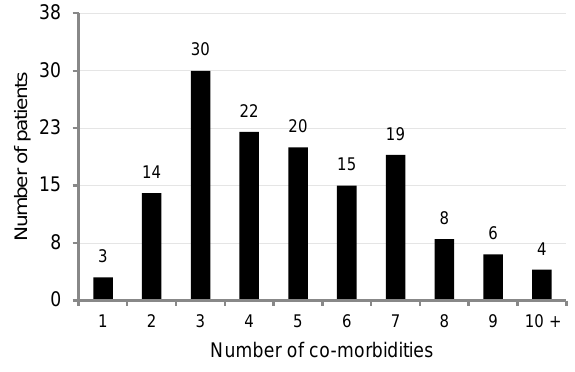
FIGURE 2: Total number of co-morbidities. Note: Maximum number of co-morbidities was 13.